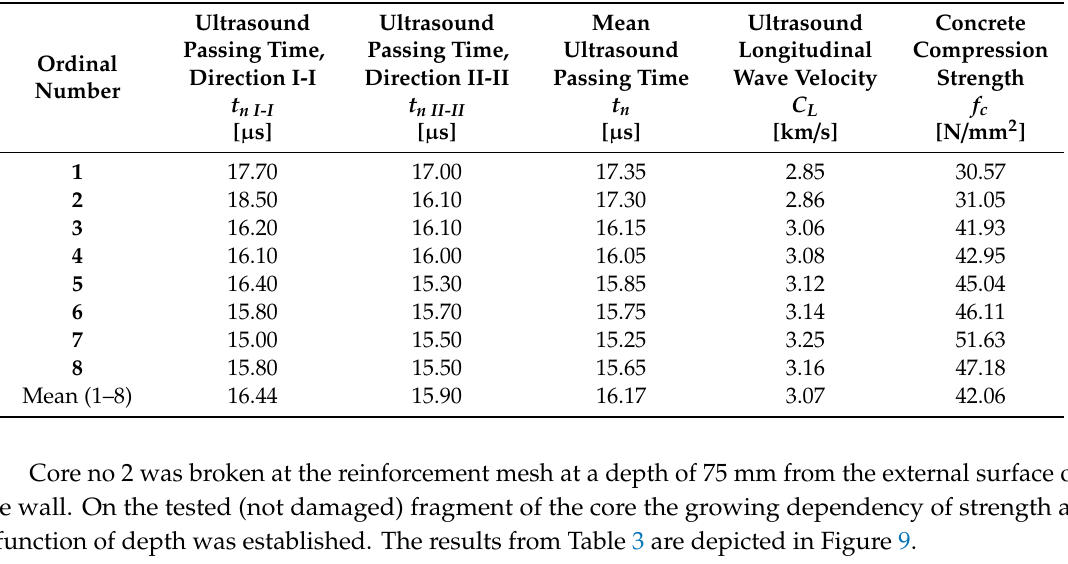
Table 4. Results of concrete compression strength test in borehole No. 2.